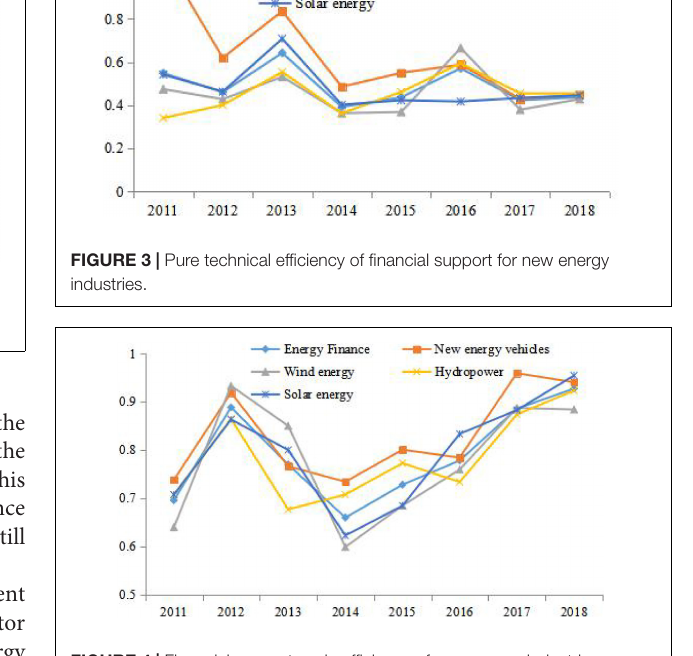
FIGURE 4 | Financial support scale efficiency of new energy